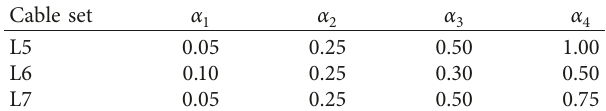
Table 3: Alpha values for each cable set.